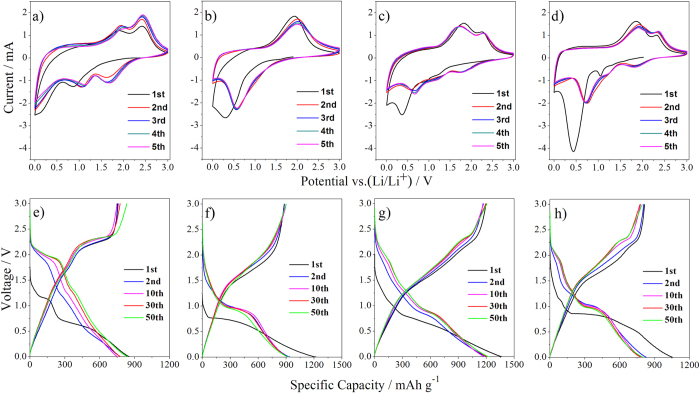
CV curves of (a) MoS2 nanosheets, (b) Fe2O3, (c) Fe2O3/MoS2 composite and (d) the physical mixture Fe2O3+MoS2, and charging–discharging curves of (e) MoS2 nanosheets, (f) Fe2O3, (g) Fe2O3/MoS2 composite and (h) the physical mixture Fe2O3+MoS2.